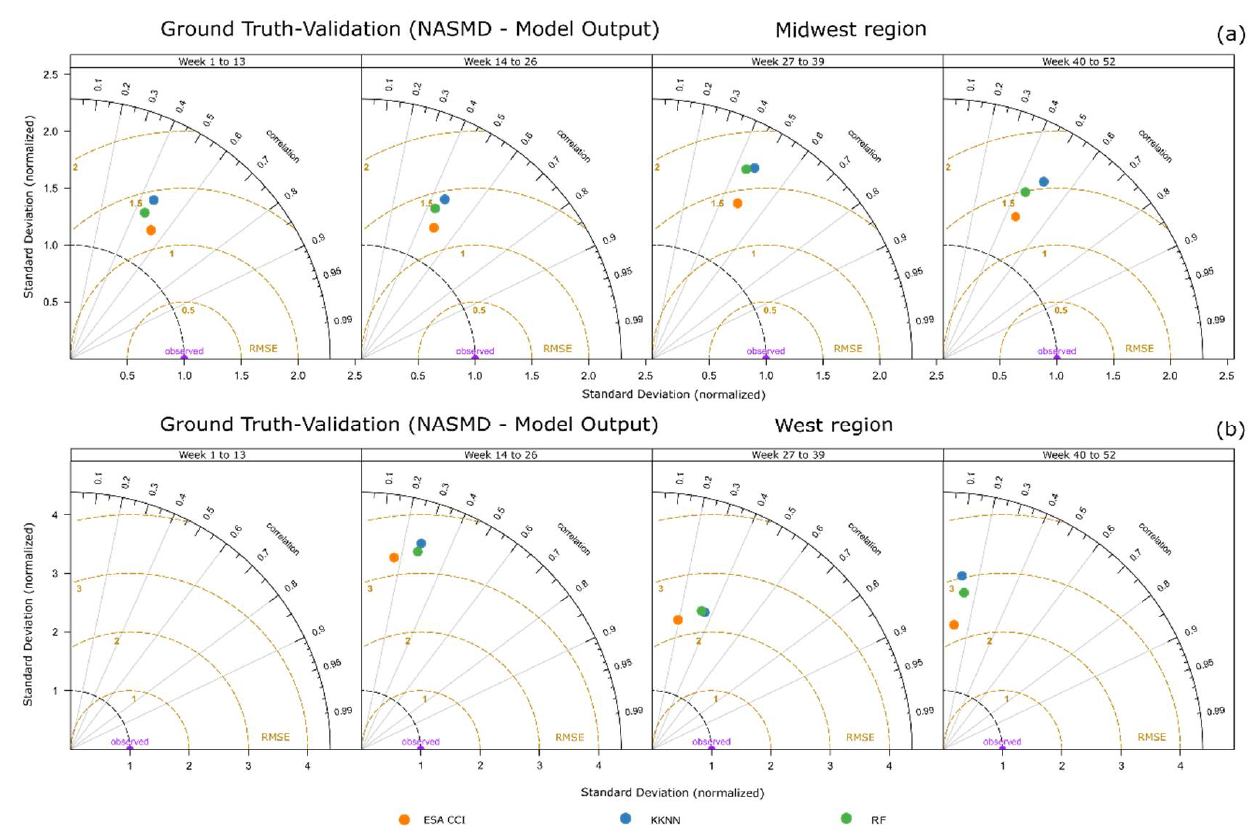
Figure 7. Taylor diagrams showing validation between weekly 1 km predicted soil moisture and ESA-CCI values, and ground-truth data from the NASMD, the 52 weekly layers are grouped in four 3-month periods; ( a ) weekly ground-truth validation of the Midwest ROI; ( b ) weekly ground-truth validation of the West ROI (correlation and RMSE values in the week 1 to 13 period were consistently negative and values are described in Section 3.2.2).